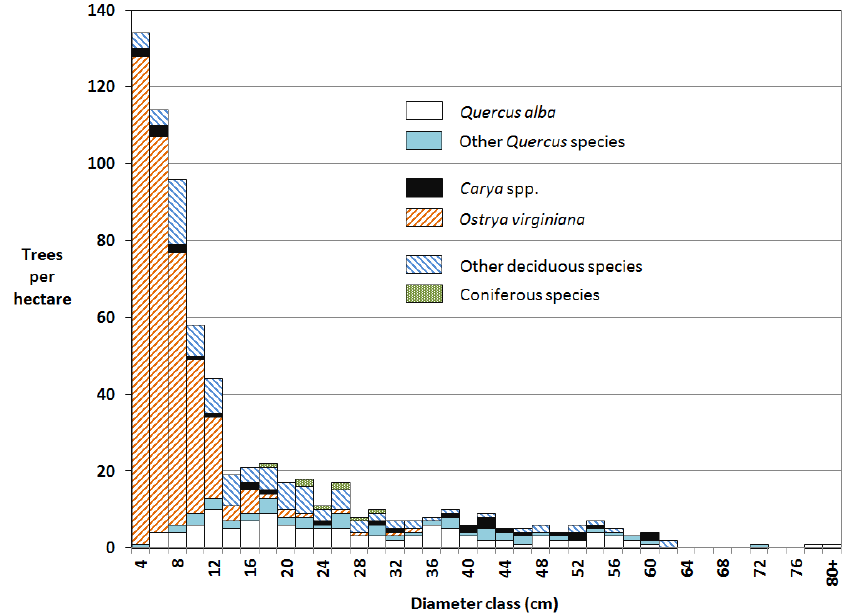
Figure 2. Diameter distribution for the uneven-aged oak-hickory stand in Georgia (eastern United